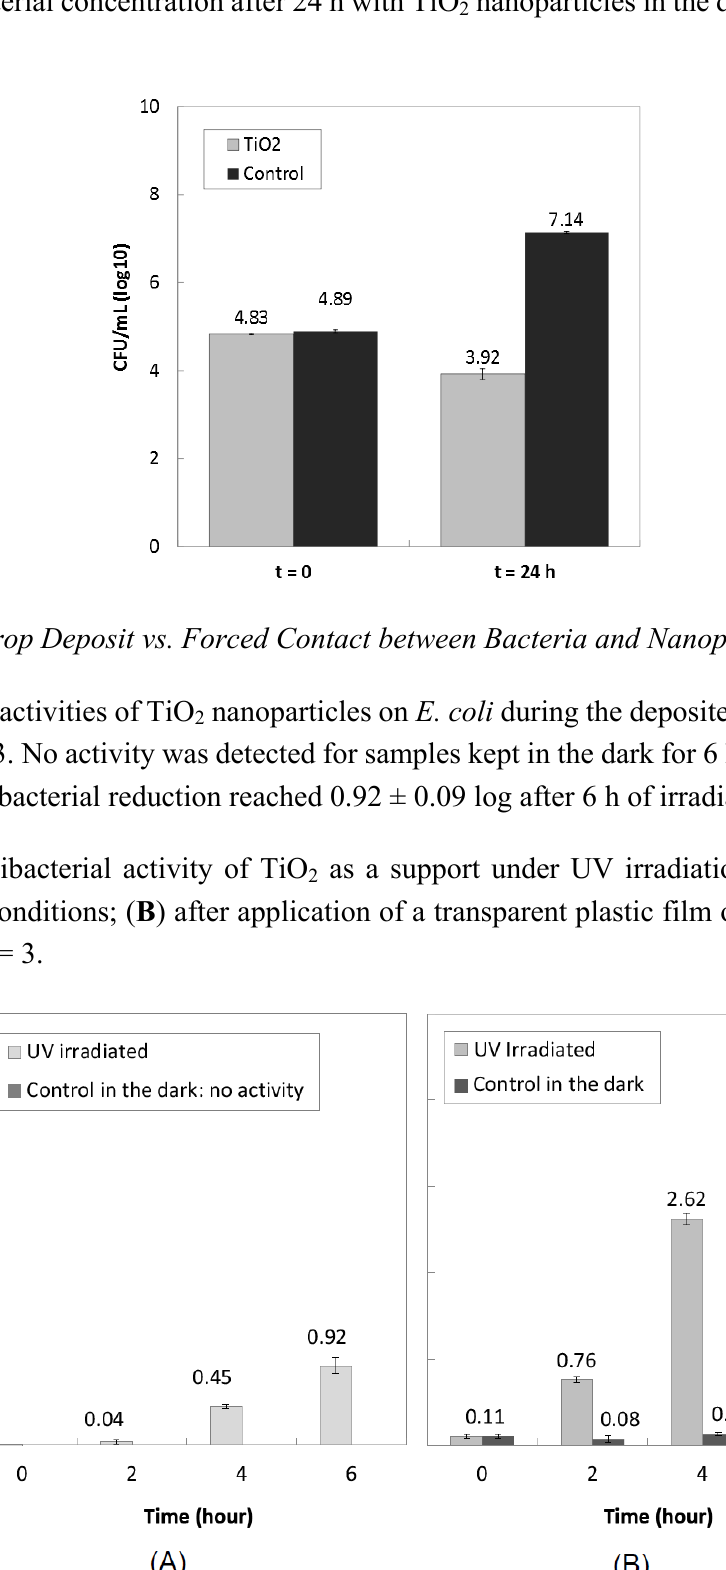
nanoparticles in the dark. Mean ± SE, 2